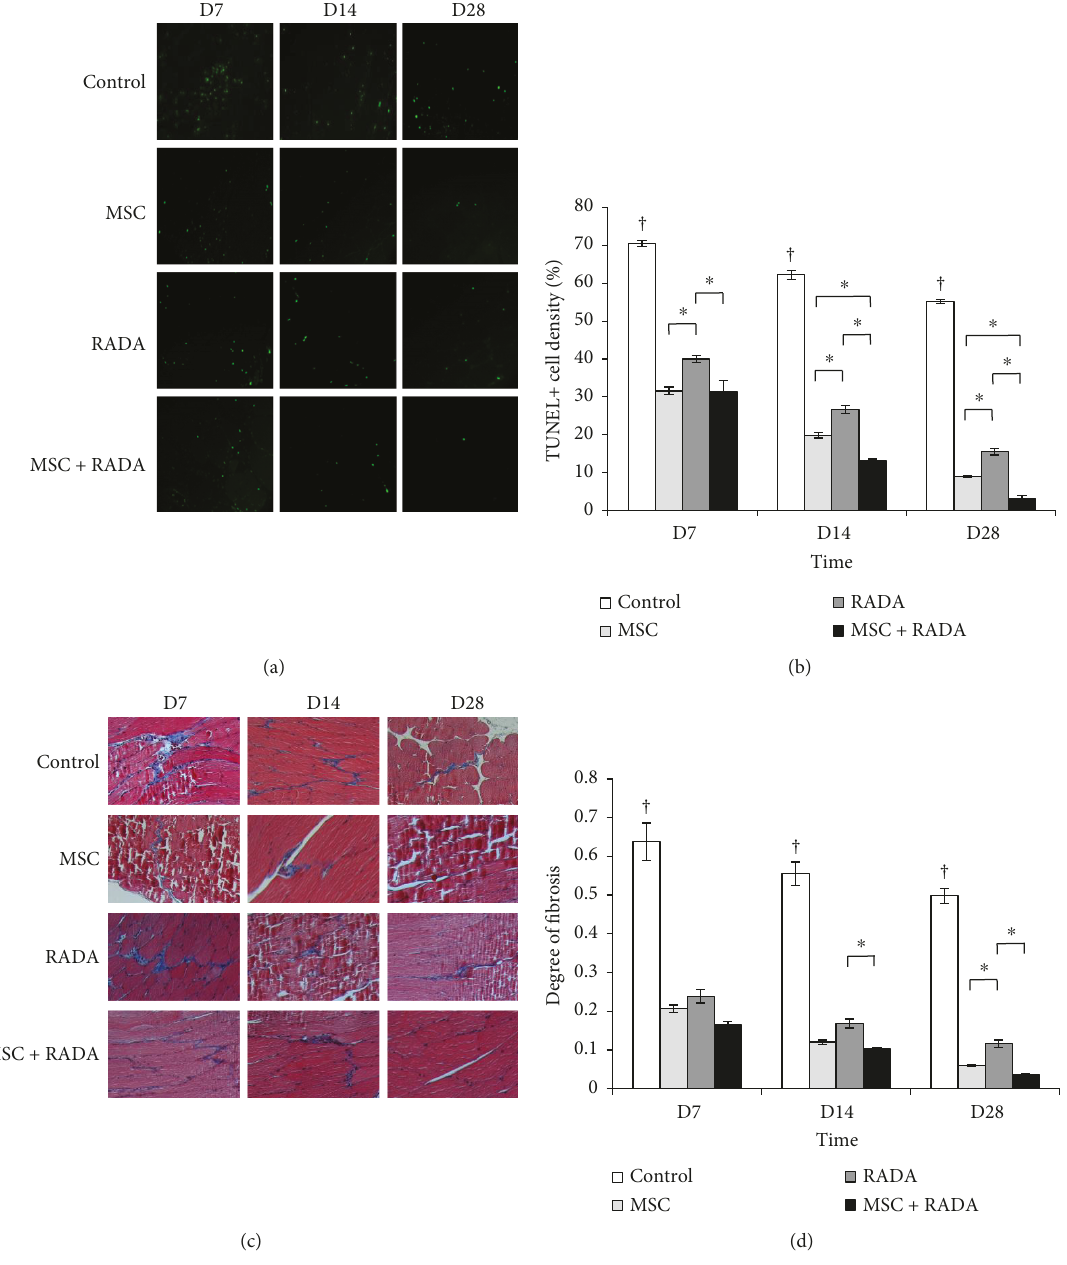
Figure 5: (a) Fluorescent TUNEL staining and (b) quanti fi cation of TUNEL-positive stains for the evaluation of apoptosis for MSCs, RADA, MSCs+RADA, and control. There is a statistically signi fi cant lower rate of apoptosis in the MSC +RADA group compared to MSCs or RADA alone. (c) Representative Masson ’ s trichrome staining showing fi brosis between muscle fi bers (10x magni fi cation) and (d) quanti fi cation of degree of fi brosis from immunohistochemical stains for the evaluation of fi brosis for MSCs, RADA, MSCs+RADA, and control. There is an overall tendency for lower fi brosis formation in the MSC +RADA group compared to MSCs or RADA alone. Lower degree of fi brosis and apoptosis correlates with an improvement in limb perfusion from increased angiogenesis. † p < 0 05 for control versus all other groups. ∗ p < 0 05